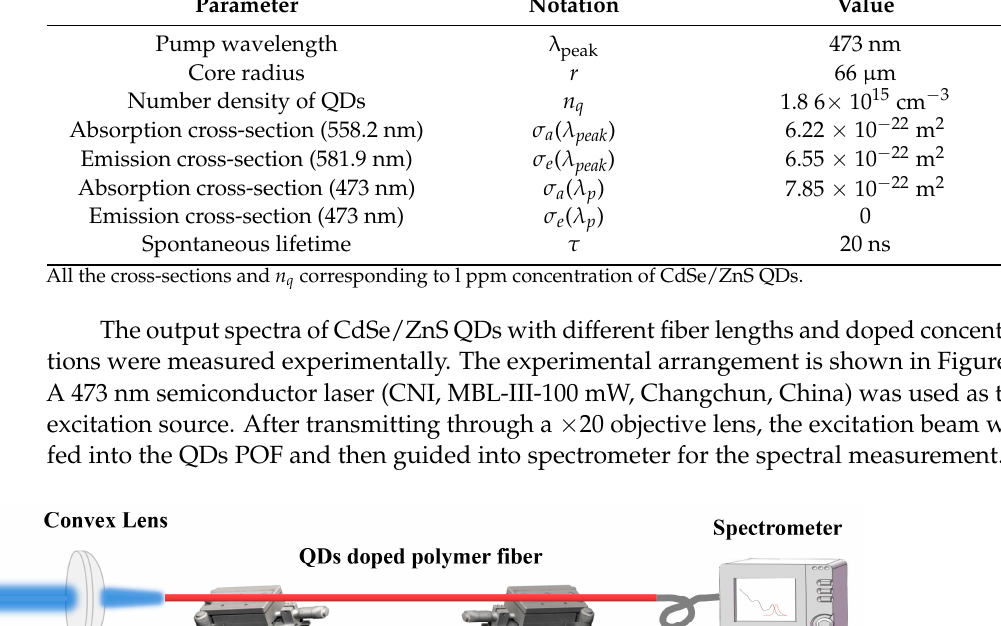
Table 1. Parameter values used in the simulation.